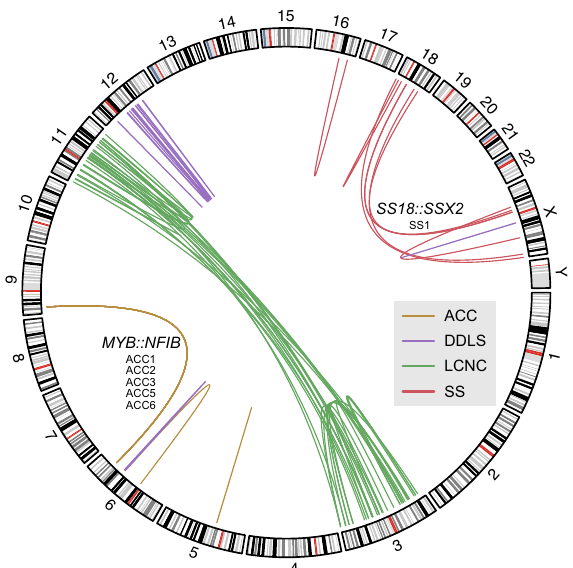
Figure 4. Visualization of structural variations. The segments in the circle represent the cytogenetic ideograms of chromosomes, oriented clockwise from start to end position and numbered consecutively. Intrachromosomal and interchromosomal rearrangements detected by the JAFFAL pipeline are represented by curves connecting the estimated breakpoints. In ACC samples (brown), the rearrangement between chromosomes 6 and 9 giving rise to the disease-defining MYB::NFIB fusion was observed. In sample SS1 (red), the characteristic SS18::SSX2 fusion was observed as a result of a rearrangement between chromosomes 18 and X. Several